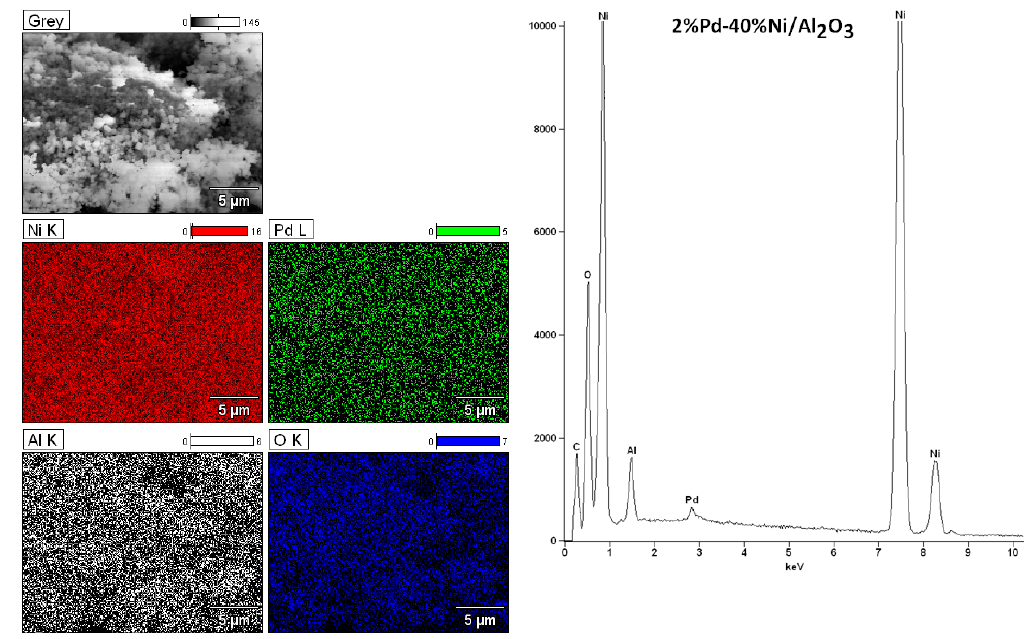
Figure 8. scanning electron microscope (SEM) images and energy dispersive spectrometer (EDS)